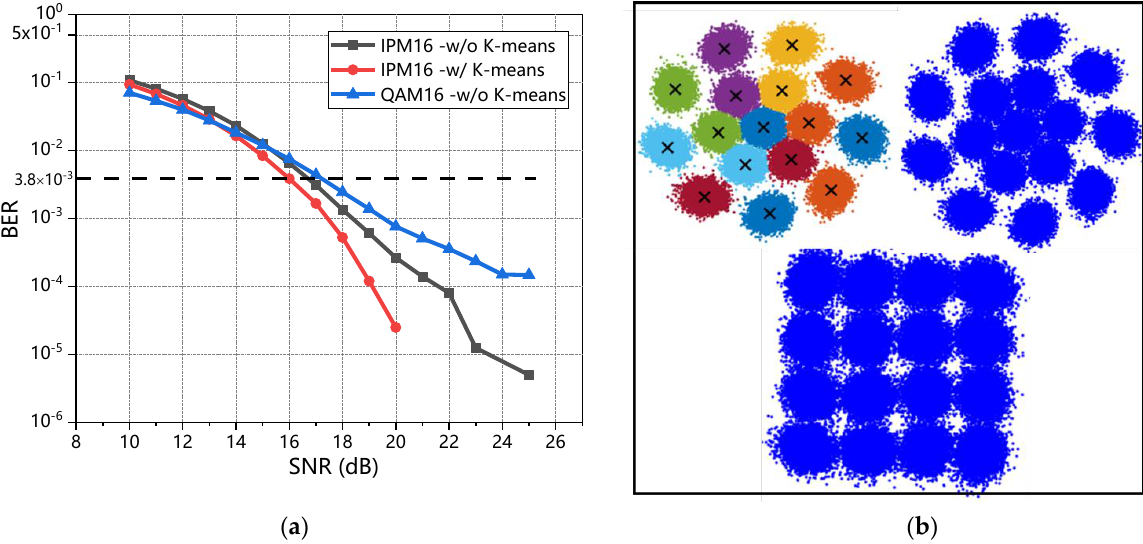
Figure 5. ( a ) BER versus SNR at loop = 5; ( b ) recovery constellation at SNR = 16dB; black intersections: ideal constellation points under impacting by NLPN (associated centroids); colored dots: the signals in the cluster associated with the nearest black intersections.